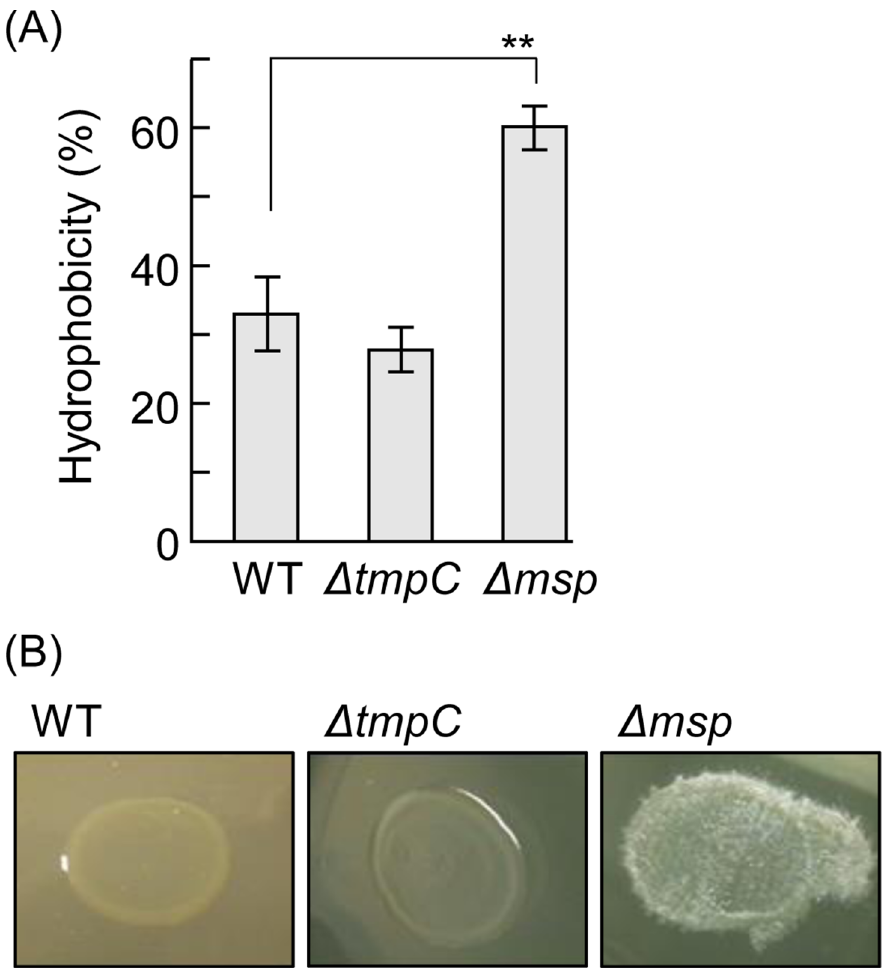
Figure 5. Cell surface hydrophobicity. (A) Cell surface hydrophobicity was quantified by measuring the partition coefficient of T . denticola cells between the aqueous and n -hexadecane phases. The data presented show a representative result from two independent experiments and are expressed as the means 6 SD (n=3). A Dunnett’s test was performed to compare the wild type and mutants (**, P , 0.01). (B) Colony appearance of T . denticola strains cultivated on a medium containing 2.5% agar. The wild type and D tmpC were smooth in appearance, whereas D msp were rough and clearly different, indicating that D msp has a hydrophobic surface.